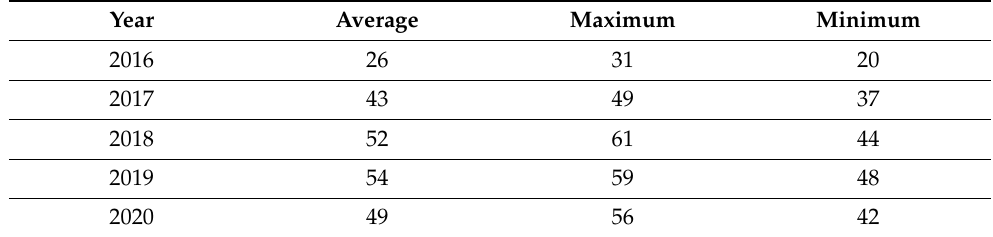
Table 1. Statistics on the number of days available over the period from 15 April to 30 October after removing the dates impacted by clouds. Filtering is carried out at the pixel level and the statistics have been calculated on all pixels of the Crau